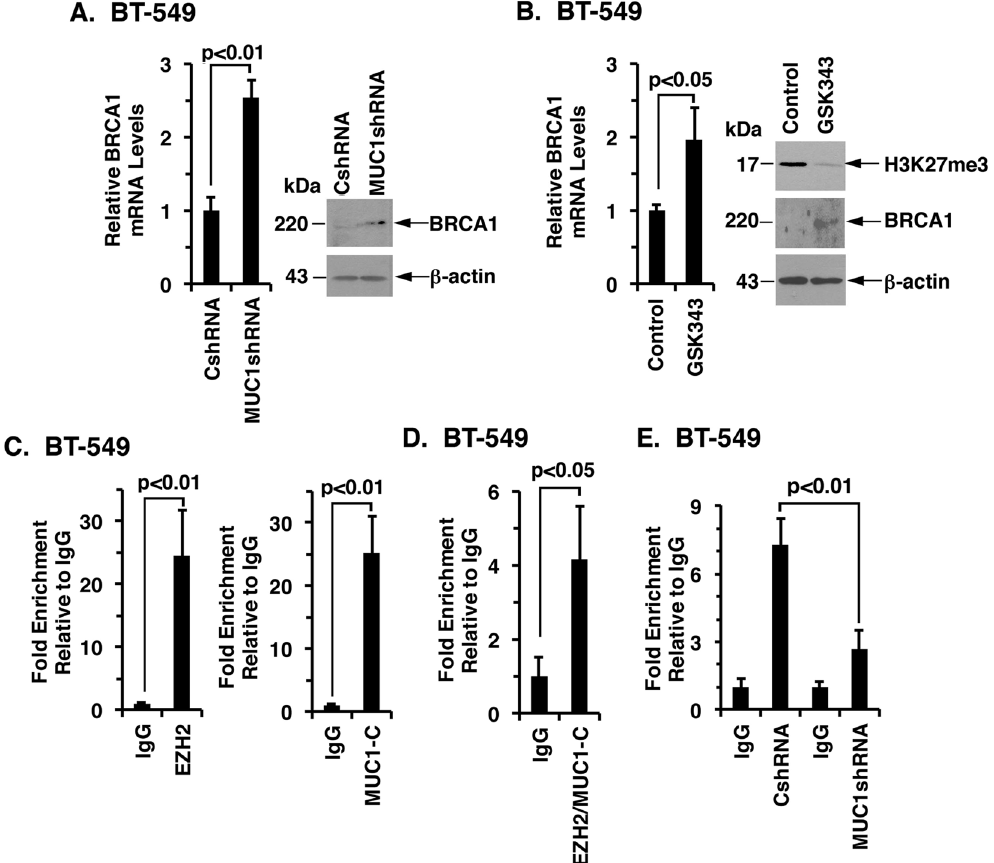
Figure 7. Targeting MUC1-C activates the BRCA1 promoter by suppressing EZH2 occupancy and H3K27me3 levels. ( A ) BT-549/CshRNA and BT-549/MUC1shRNA cells were analyzed for BRCA1 mRNA levels by qRT- PCR. The results (mean ± SD) are expressed as relative mRNA levels compared to that obtained for the CshRNA cells (assigned a value of 1) (left). Lysates were immunoblotted with the indicated antibodies (right). ( B ) BT-549 cells treated with vehicle control or 10 μ M GSK343 for 72 h were analyzed for BRCA1 mRNA levels by qRT- PCR. The results (mean ± SD) are expressed as relative mRNA levels compared to that obtained for the Control cells (assigned a value of 1) (left). Lysates were immunoblotted with the indicated antibodies (right). ( C ) Soluble chromatin from BT-549 cells was precipitated with anti-EZH2 (left), anti-MUC1-C (right) or a control IgG. ( D ) In the re-ChIP analysis, EZH2 precipitates were released and re-immunoprecipitated with anti-MUC1-C and a control IgG. ( E ) Soluble chromatin from BT-549/CshRNA and BT-549/MUC1shRNA cells was precipitated with anti-H3K27me3 or a control IgG. The final DNA samples were amplified by qPCR with primers for the BRCA1 promoter. The results (mean ± SD of three determinations) are expressed as the relative fold enrichment compared with that obtained with the IgG control (assigned a value of